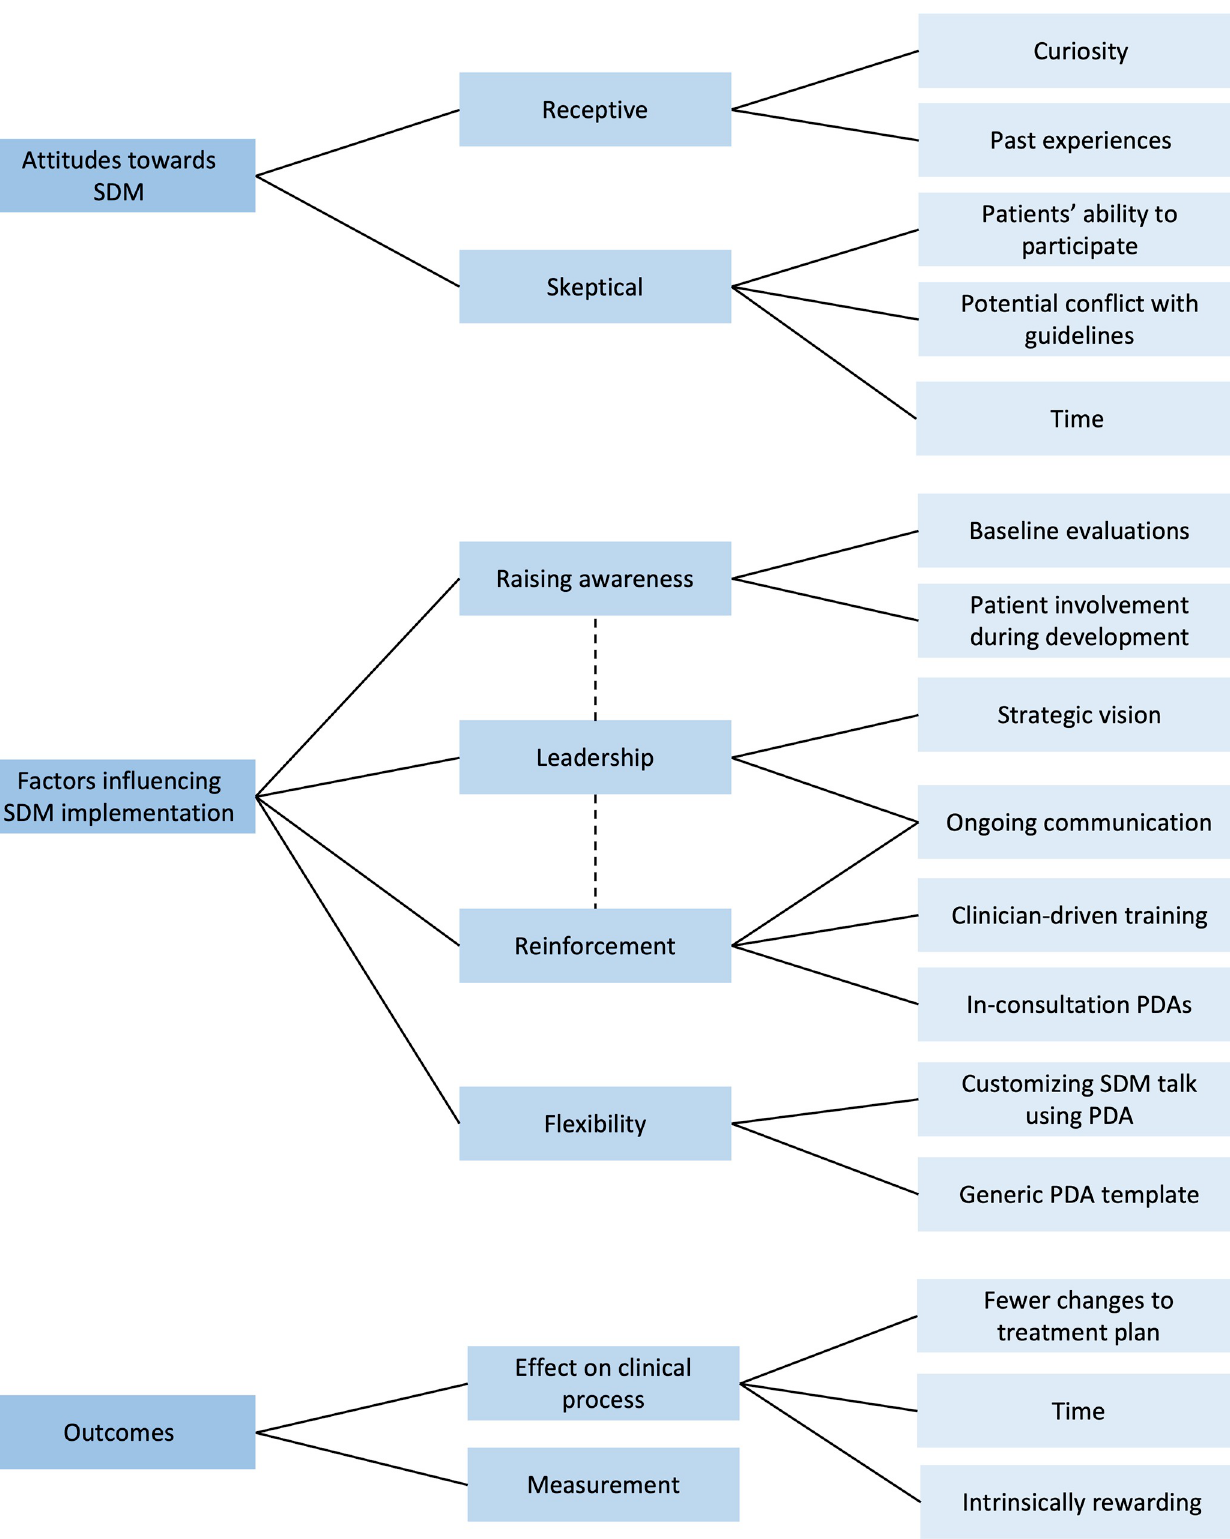
PLOS ONE | https://doi.org/10.1371/journal.pone.0259844 November11,